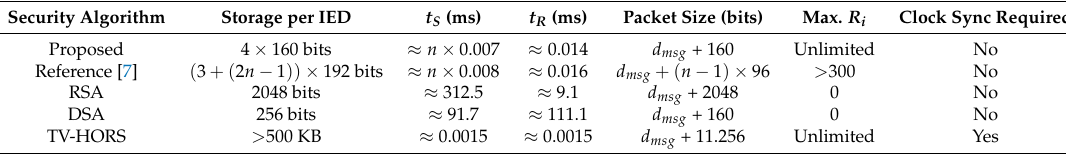
Table 3. Comparative Analysis of Microgrid Security Algorithms.